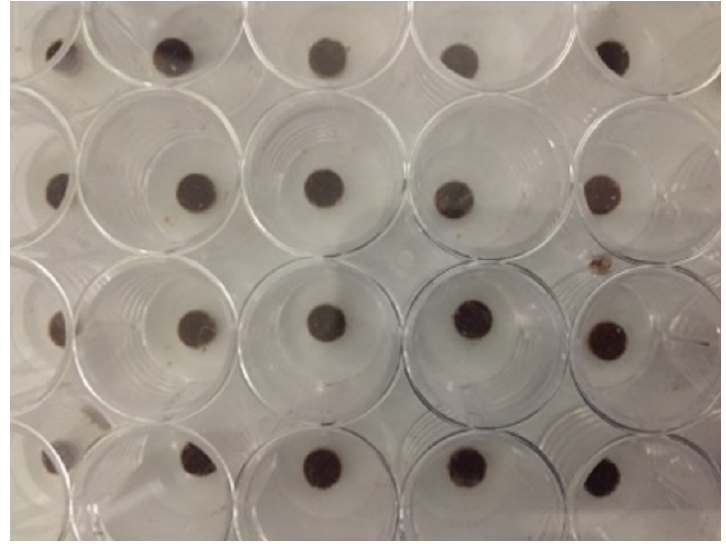
Figure 1. Lignocellulosic biopolymeric membranes 6 mm Ø deposited in transwell inserts in 24-well culture plate.